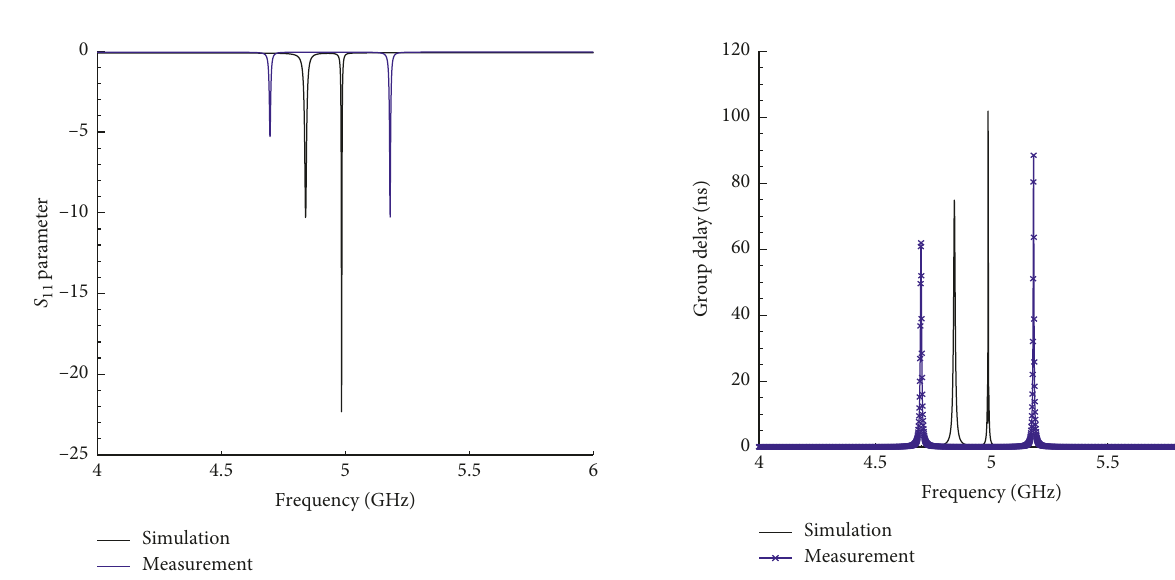
Figure 12: Measured and simulated frequency responses of third proposed resonator (structure a).